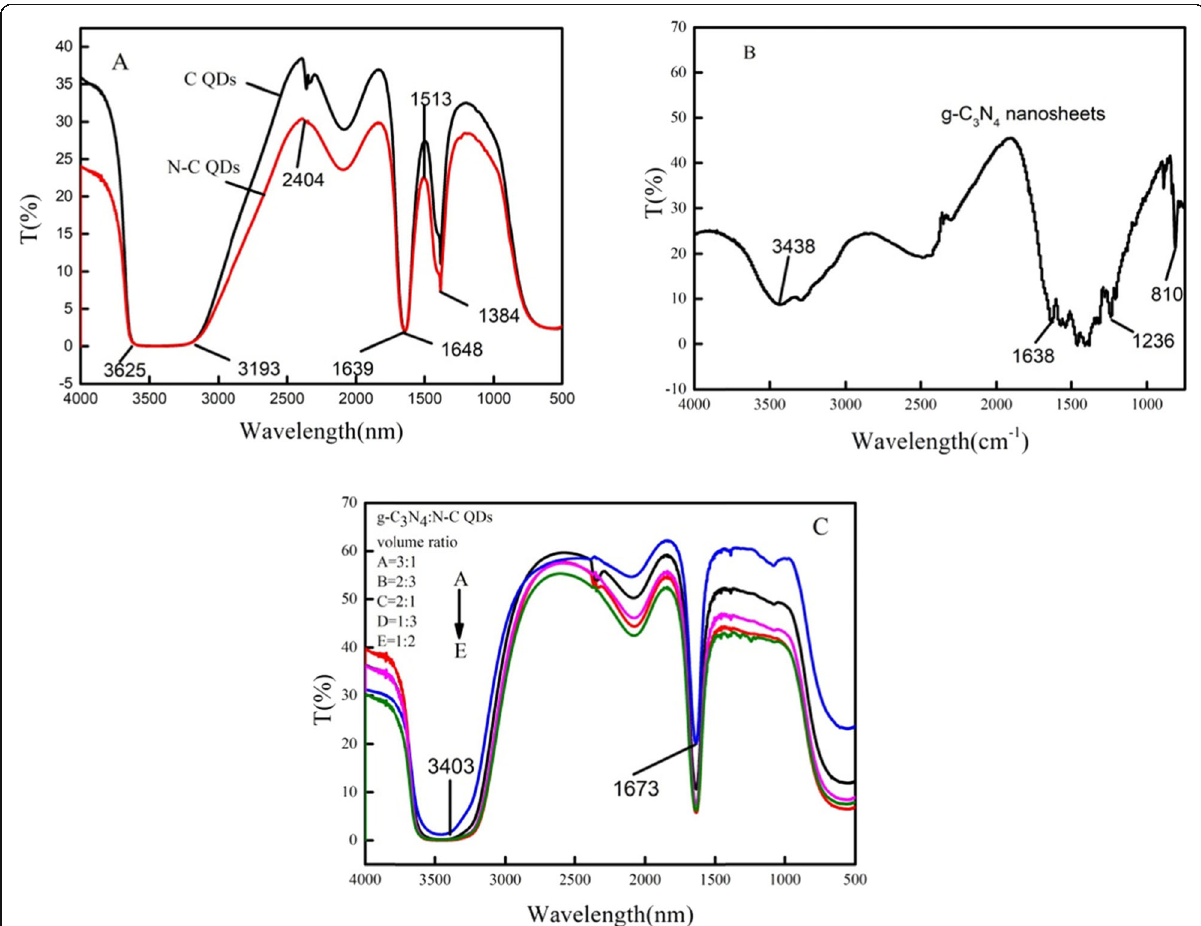
Fig. 1 FTIR of C QDs and N-C QDs ( a ), g-C 3 N 4 nanosheets ( b ) and g-C 3 N 4 : N-C QDs composites ( c